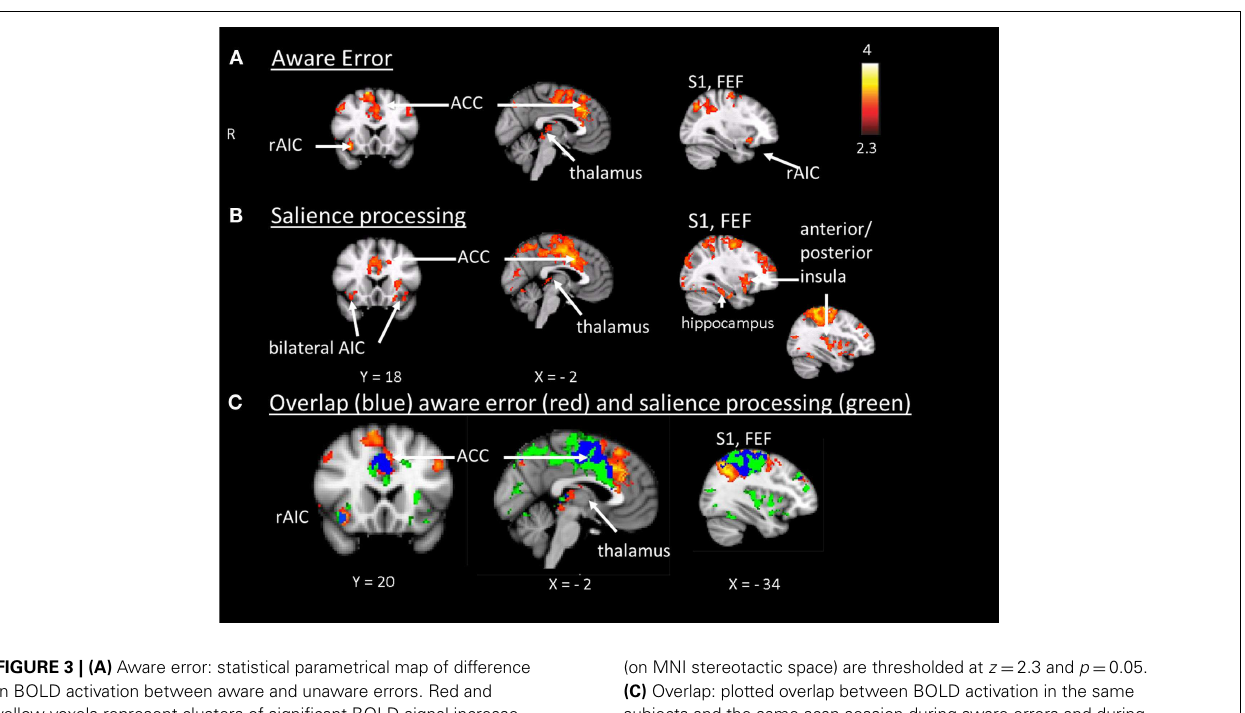
FIGURE 3 | (A) Aware error: statistical parametrical map of difference in BOLD activation between aware and unaware errors. Red and yellow voxels represent clusters of significant BOLD signal increase. (B) Salience processing: statistical parametrical map of difference in BOLD activation for the parametrical oddball. Red and yellow voxels represent clusters of significant BOLD signal increase. Renderings